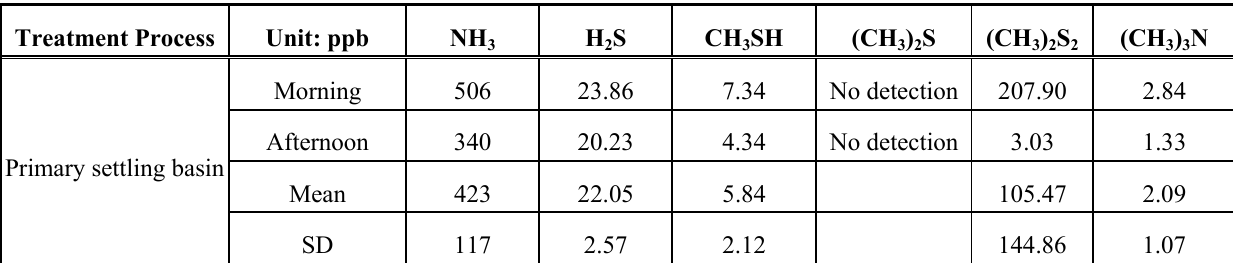
Table 4. Measurements of the Selected Odorous Compounds during Summer